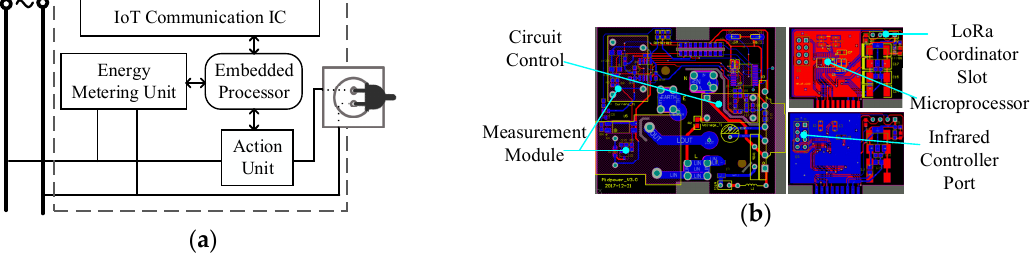
Figure 5. Smart terminal for the proposed DR system: ( a ) schematic of key blocks and functions in the smart terminal; ( b ) circuit diagram of its implementation.